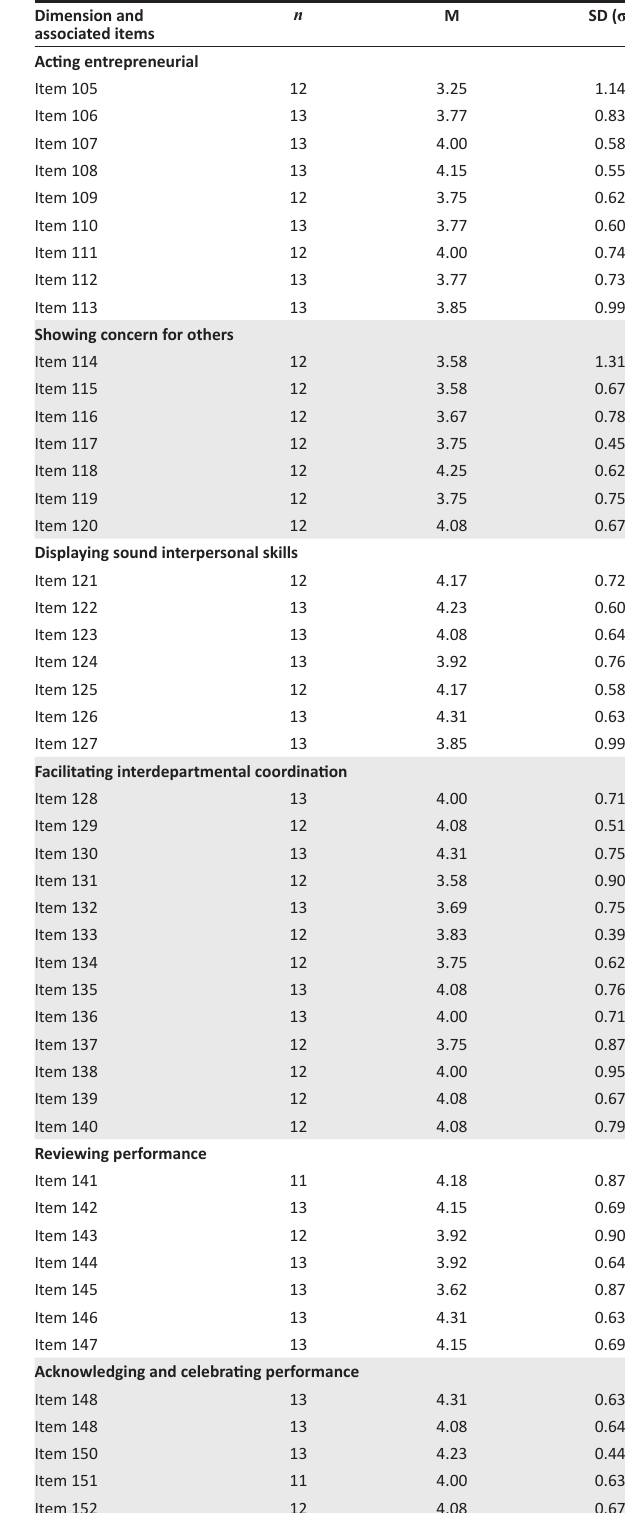
TABLE 3 (Continues...): Descriptive statistics results for item ratings by expert judges. Dimension and associated items